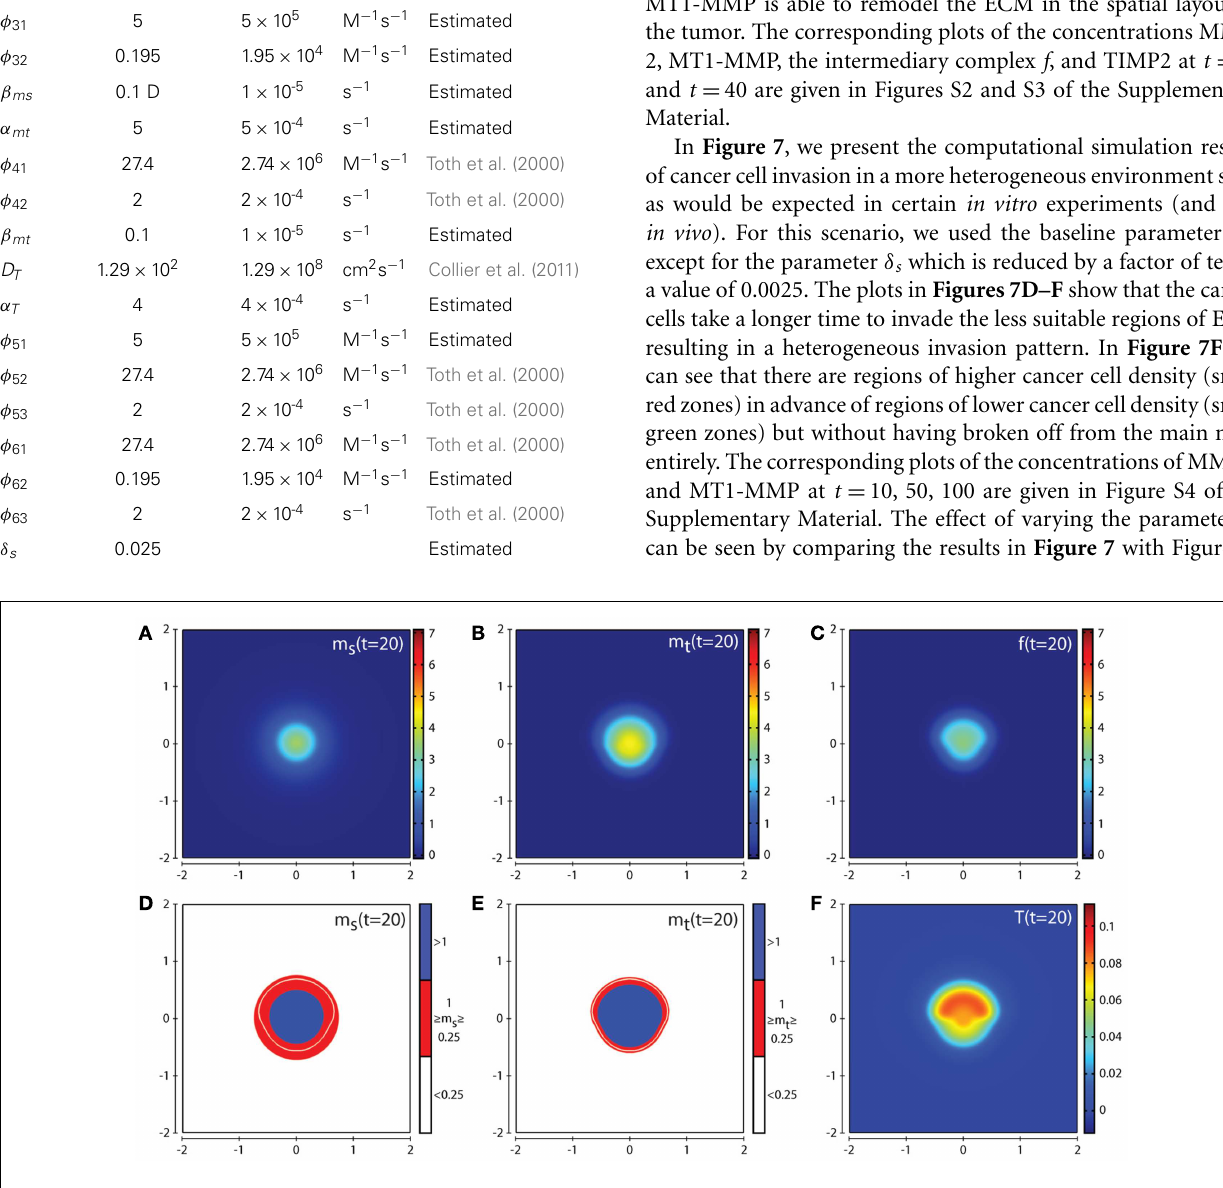
MMP-2 and MT1-MMP concentrations at t = 20 with appropriate thresholds near the invasive front of the cancer cell invasion.The white contour line shows the cancer cell density at level 0.01 chosen to represent the maximum extent of invasion. Simulations are performed using the baseline parameter